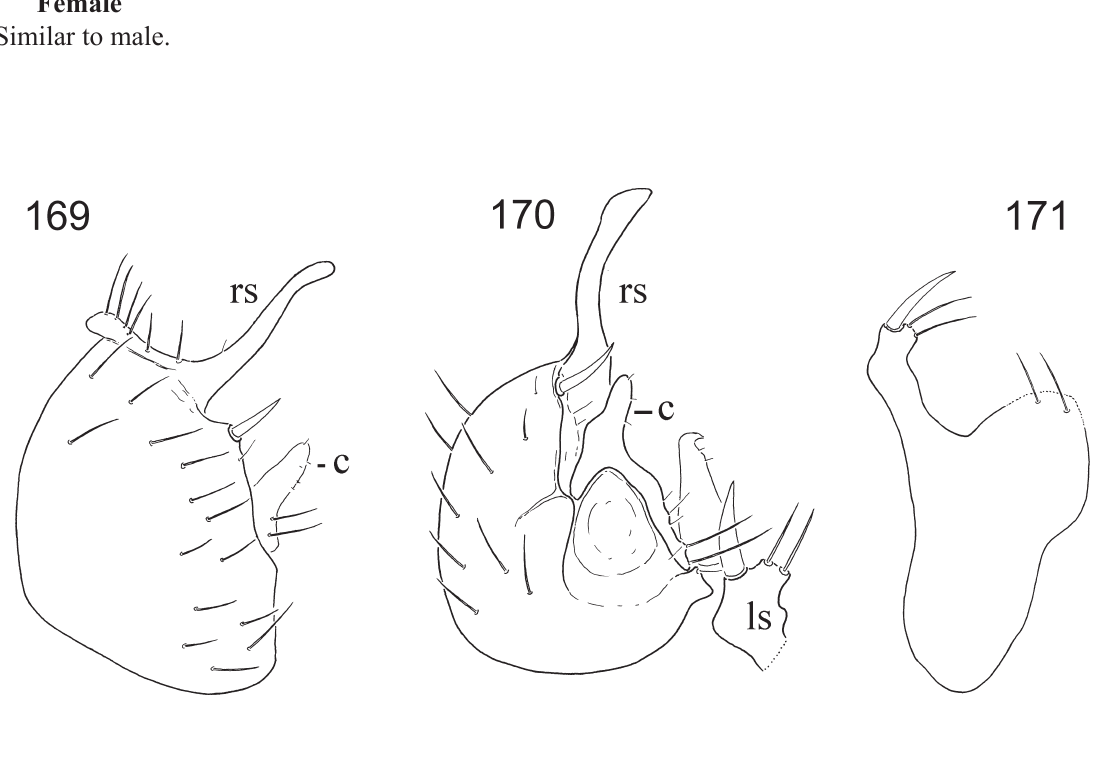
Figs 169-171. Nanodromia hutan sp. nov., ♂ terminalia. 169 . right epandrial lamella, lateral view. 170 . epandrium with cerci, dorsal view. 171 . left surstylus, lateral